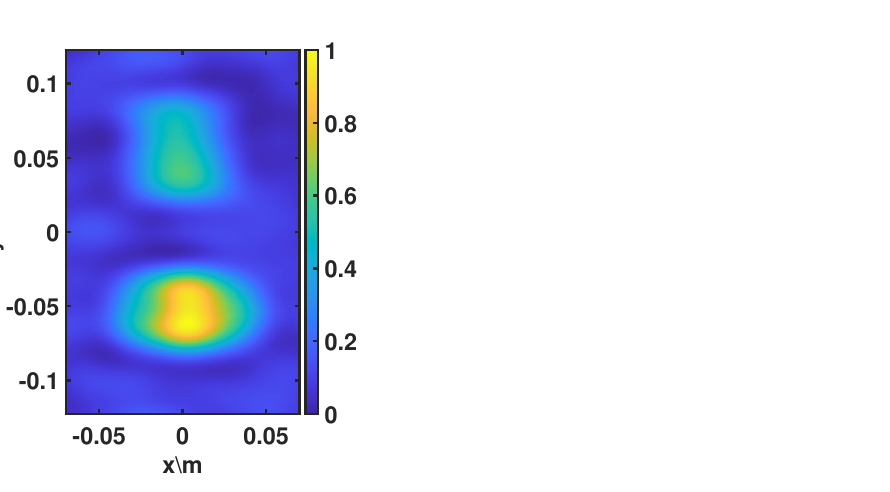
Figure 13. The imaging result generated by far-field imaging